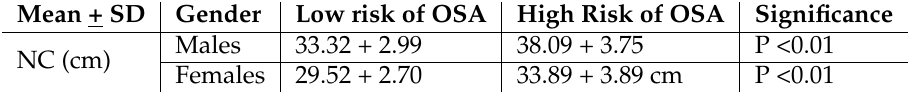
Table 1. Independent t test showing association of NC with risk of OSA in both males & females Mean + SD Gender Low risk of OSA High Risk of OSA Significance Males 33.32 + 2.99 38.09 + 3.75 P <0.01 NC (cm) Females 29.52 + 2.70 33.89 + 3.89 cm P <0.01